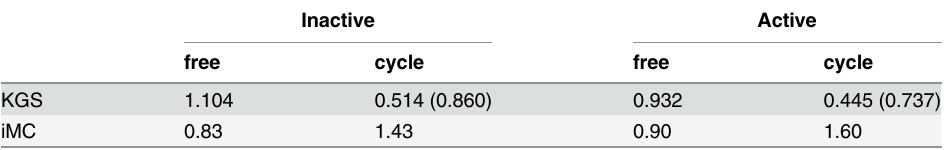
Table 1. Mean KGS and iMC RMSF (measured in degrees) for free and cycle DoFs in the active and inactive